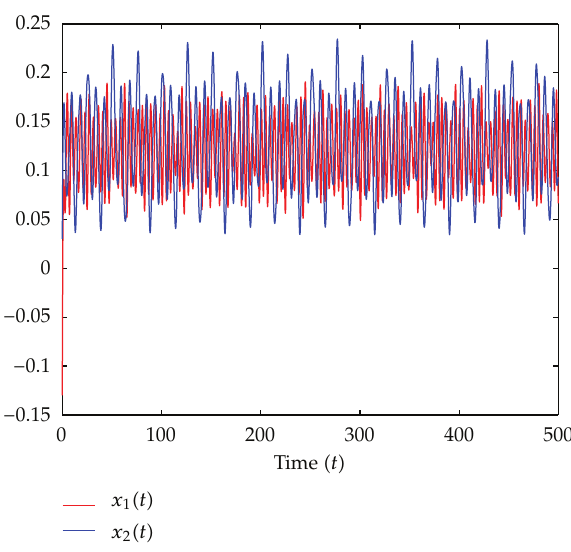
Figure 1: Transient response of state x 1 ,x 2 in Example